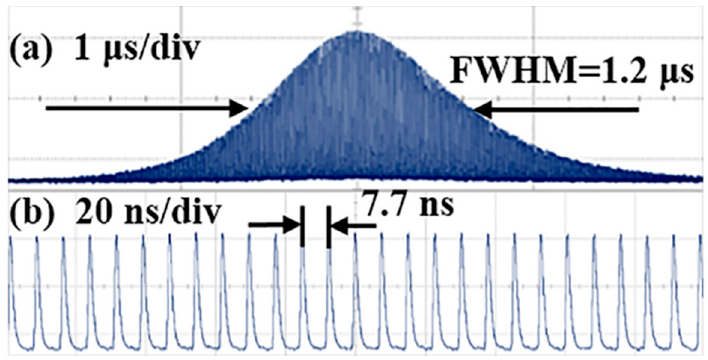
Figure 5. ( a ) The typical QML pulse and ( b ) expanded oscilloscope traces of mode locked pulses.